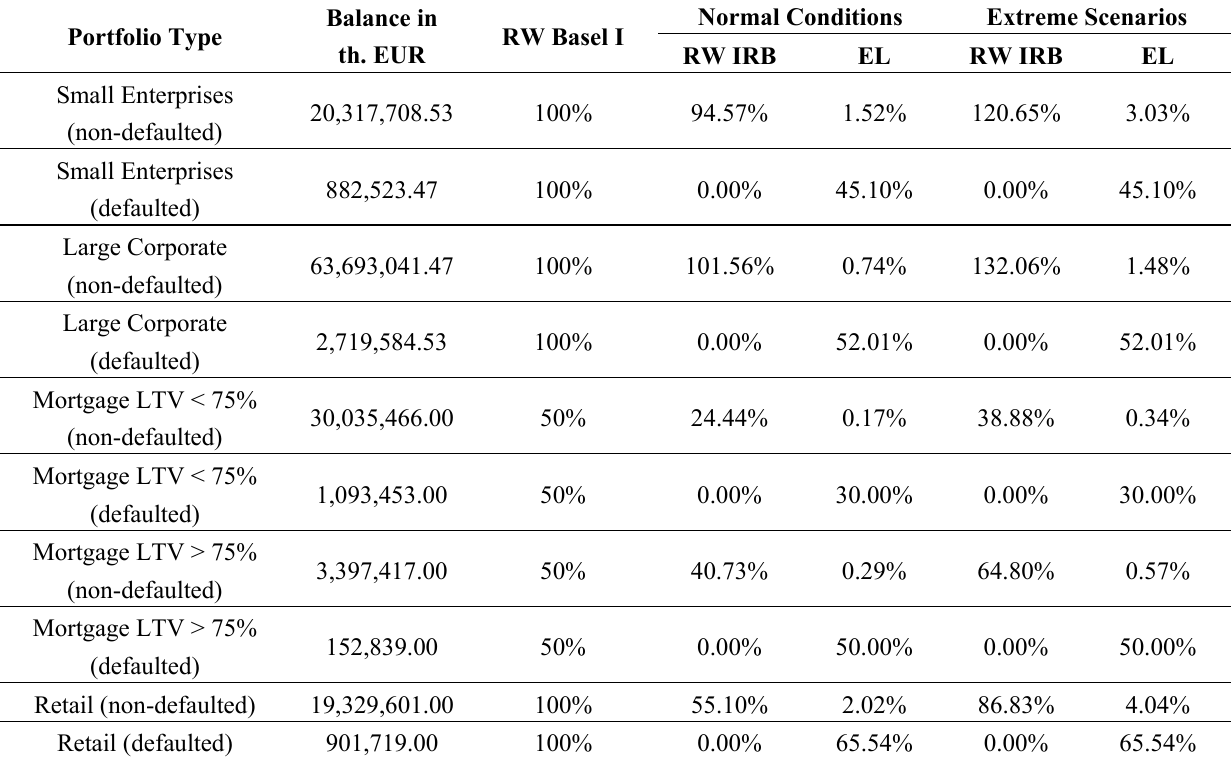
Table 2. Bank 1: RW analysis per portfolio for normal conditions and extreme